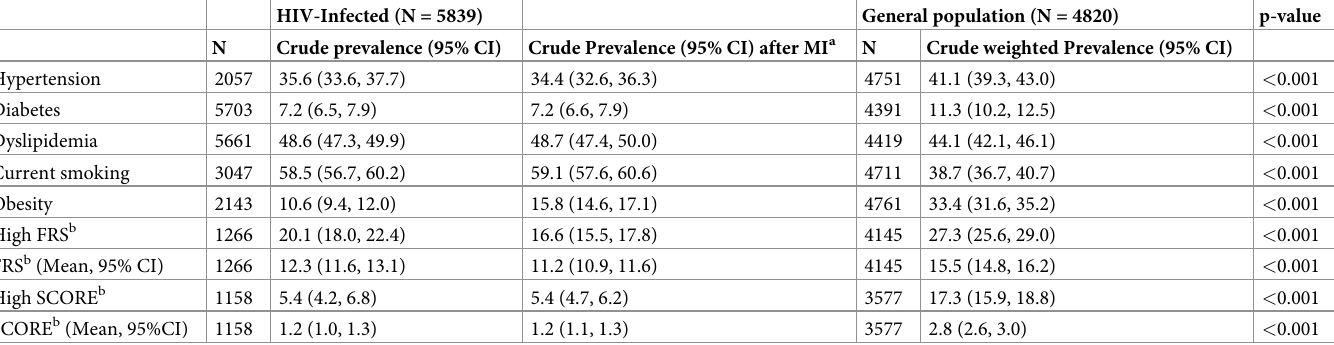
Table 2. Number of people with available data and crude prevalence (%) of cardiovascular disease (CVD) risk factors and of risk of CVD by